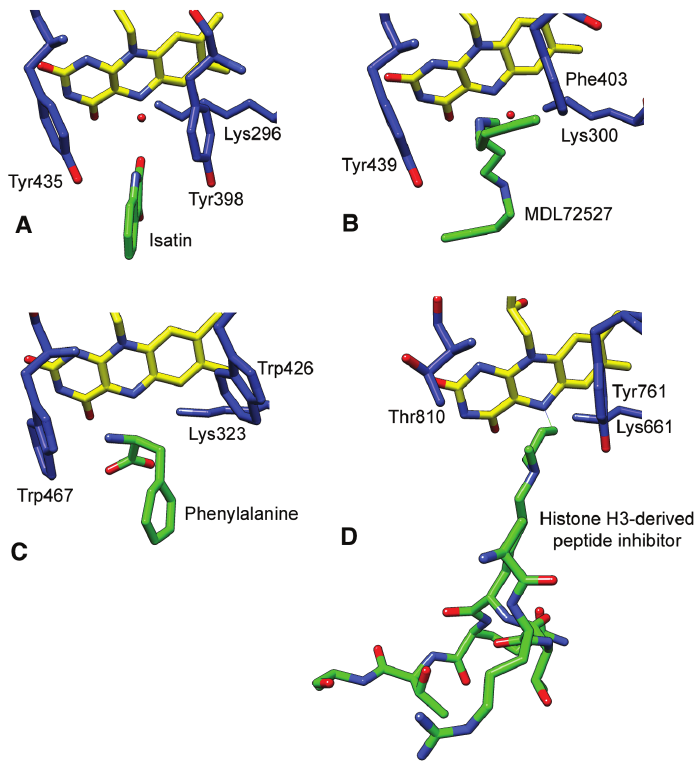
Figure 2 The active sites of human MAO B (A, PDB file 1OJA), maize PAO (B, PDB file 1B5Q), bacterial LAAO (C, PDB file 2JB2), and human LSD1 (D, PDB file 2UXN) with bound substrates or inhibitors